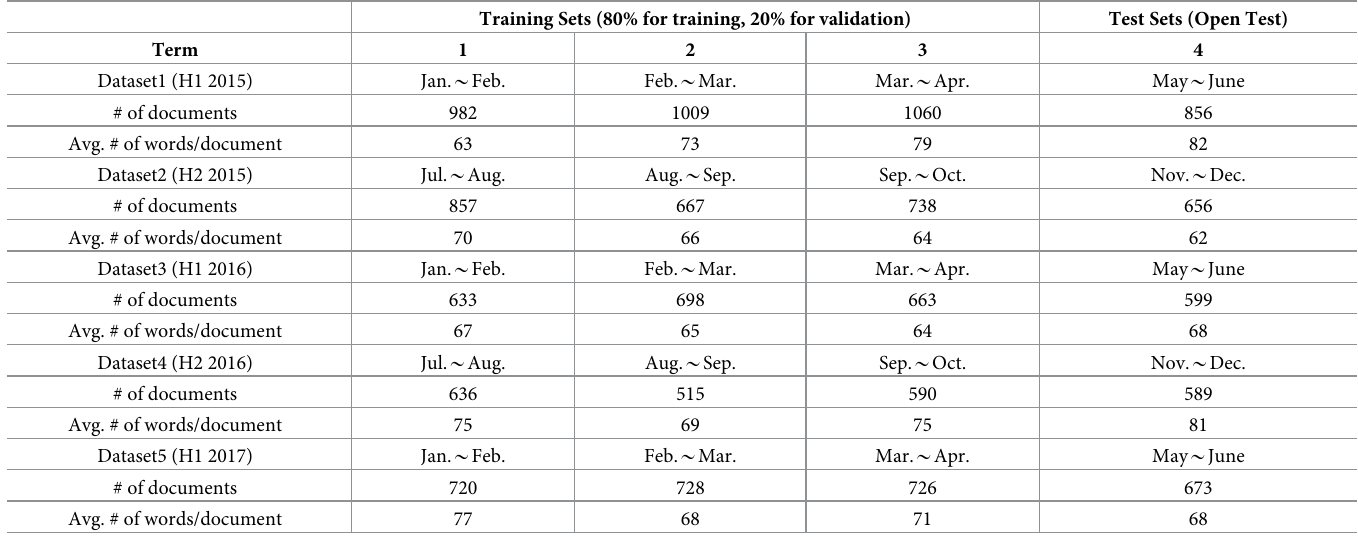
Table 2. Overview of datasets for stock price prediction.